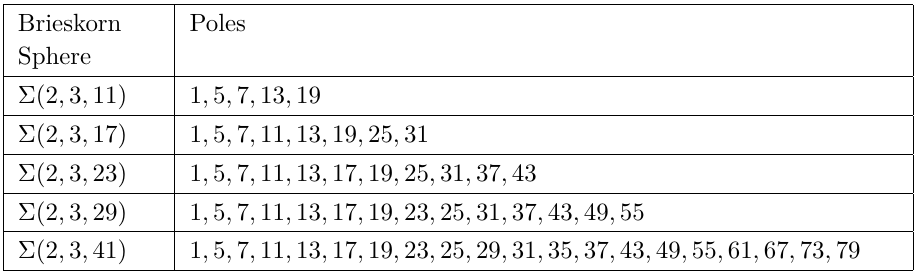
Table 1. The first five of Brieskorn spheres Σ(2 , 3 , 6 n + 5) and their corresponding family of poles that contribute to their irreducible SL(2 , C ) connections.